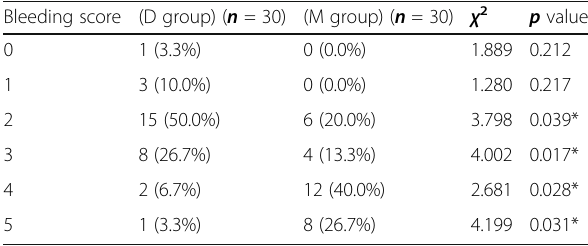
Table 6 Comparison between both groups regarding the bleeding score Bleeding score (D group) ( n = 30) (M group) ( n = 30) χ 2 p